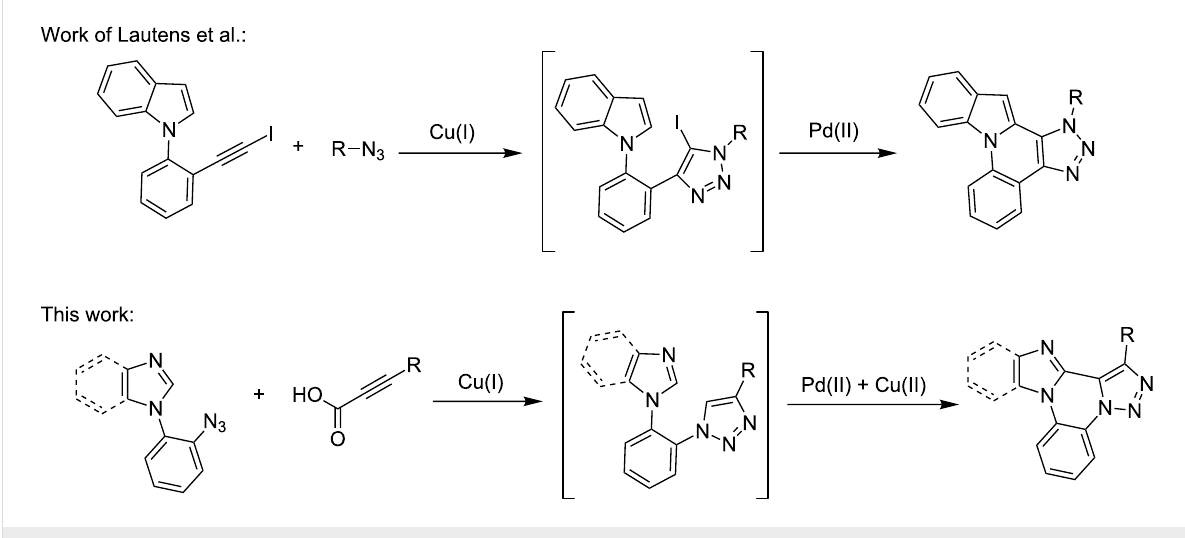
Scheme 1: Synthesis of polycyclic fused